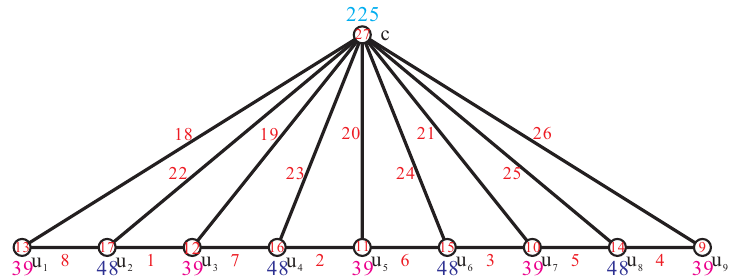
Figure 2. The local antimagic total labeling of F 9 .